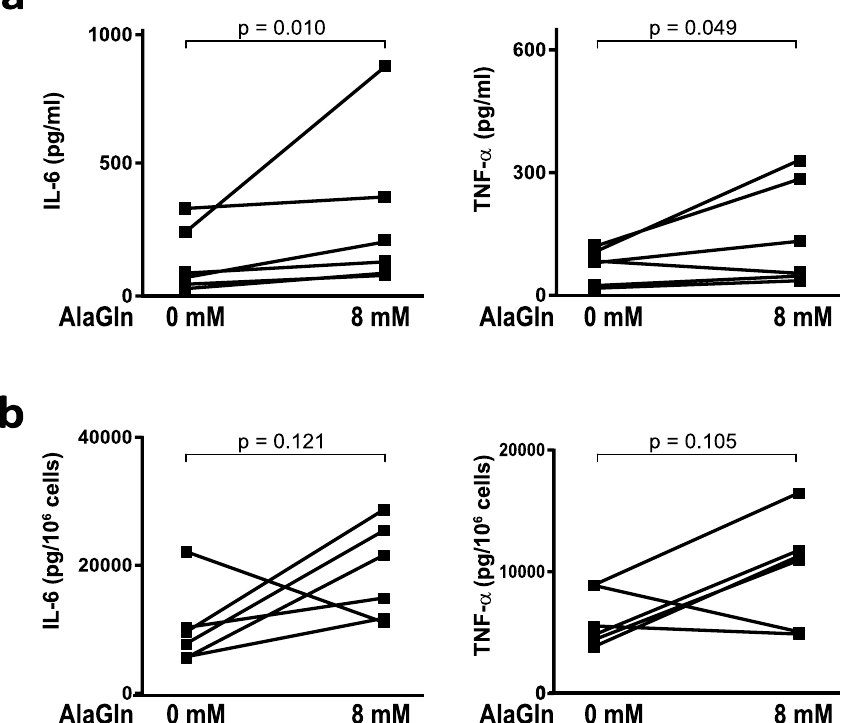
Figure 4. Effect of AlaGln supplementation on ex-vivo stimulated cytokine release. ( a ) Levels of IL-6 (left) and TNF- α (right) in 9 ml effluent samples of the 1 h PET dwell without (0 mM) or with (8 mM) AlaGln supplemented PDF. 9 ml effluent samples were directly stimulated with 100 ng/ml LPS plus 100 ng/ml Pam 3 Cys and incubated for 24 h at 37 °C. IL-6 release was significantly increased (p = 0.010) by addition of 8 mM AlaGln during the dwell (TNF- α , p = 0.0487). ( b ) Cytokine levels as normalized per 10 6 cells. Data show results